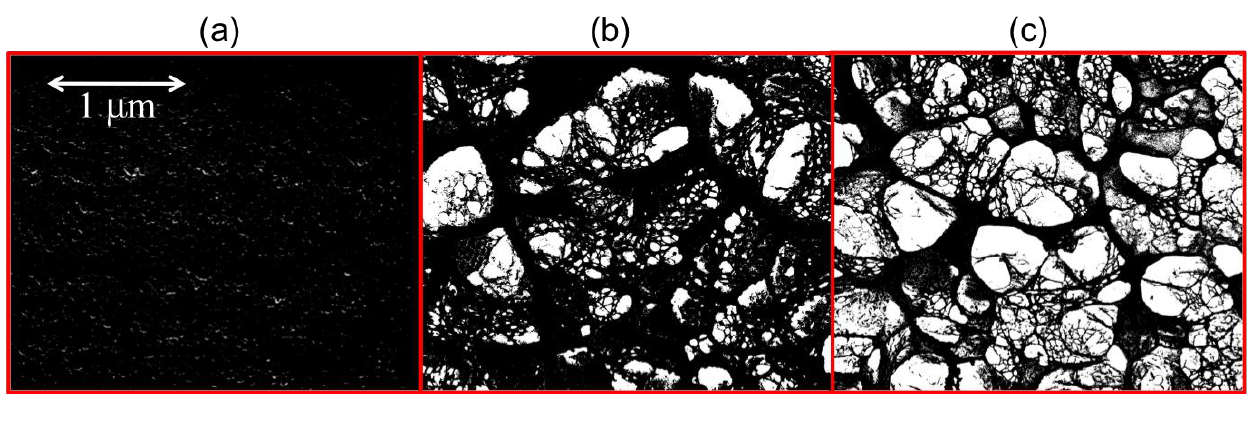
Figure 2. SEM images converted to black (hydrogel) and white (pore) scale (50000×) of the hydrogels in various glucose concentrations. (a) 0 mg/dL, ( b) 100 mg/dL, (c) 300